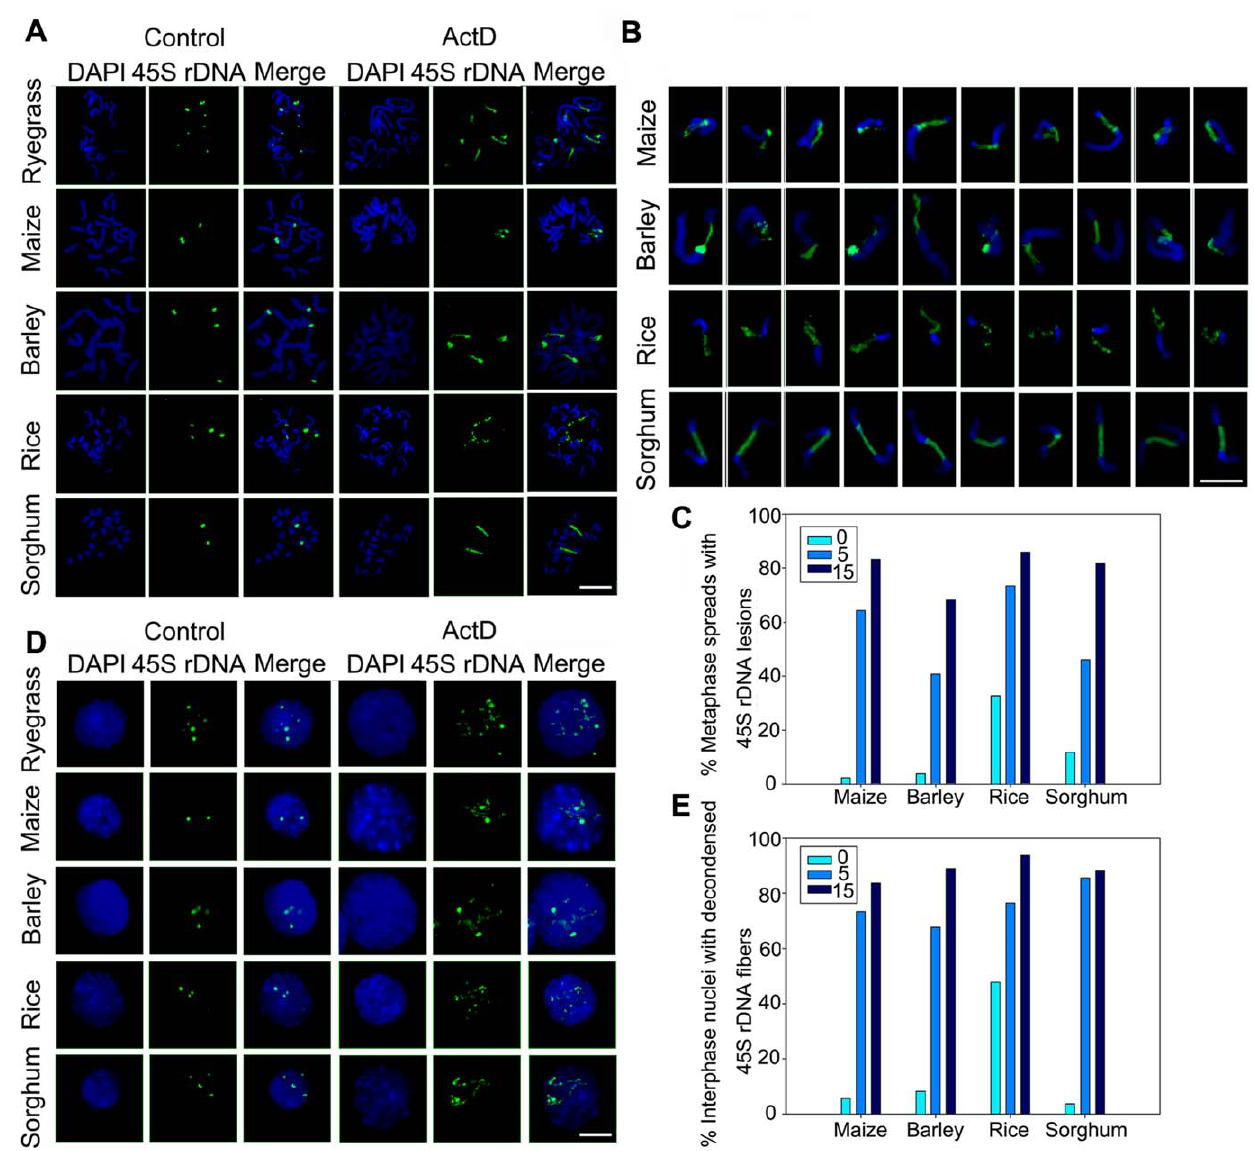
Figure 3. ActD induces 45S rDNA fragility in ryegrass, maize, barley, rice and sorghum revealed by FISH. (A) Metaphase chromosome spreads revealed aberrant 45S rDNA phenotypes induced by ActD. The 45S rDNA FISH signal was the dense spot on chromosomes in untreated plants. In contrast, ActD-treated spreads exhibited highly stretched strands of rDNA signals or breaks on chromosomes after treatment with 15 m g/ml ActD. Bar=5 m m. (B) Examples of fragile 45S rDNA phenotypes Bar=5 m m. (C) Percentages of metaphase chromosome spreads with 45S rDNA lesions after treatment without or with 5 m g/ml and 15 m g/ml ActD, respectively. Number of evaluated spreads in each group was 300. (D) ActD treatment caused aberrant 45S rDNA signal patterns in nuclei. The interphase nuclei contained compact spot signals in normal plants whereas a mass of ‘‘beads- on-a-string’’ fibers were observed throughout the nucleoplasm in interphase nuclei after treatment with 15 m g/ml ActD. Bar=10 m m. (E) Percentages of interphase nuclei with decondensed 45S rDNA fiber signals after treatment without or with 5 m g/ml and 15 m g/ml ActD, respectively. Number of evaluated nuclei in each group was 500.